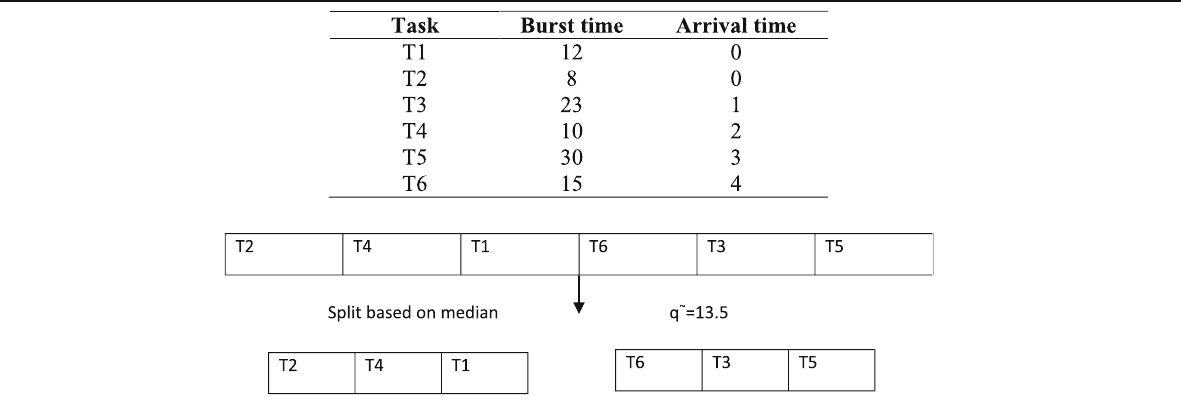
Table 1 Submitted tasks burst and arrival